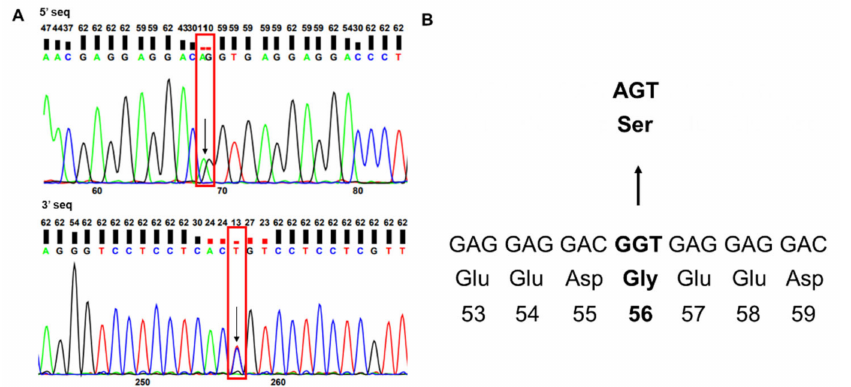
Figure 1. PSEN2 sequencing data revealing a mutation resulting in a Gly56Ser substitution are shown. ( A ) Sanger sequencing data and the ( B ) location of the Gly56Ser substitution in PSEN2 . Arrows indicate the mutation positions and the altered sequence and amino acid by mutation.